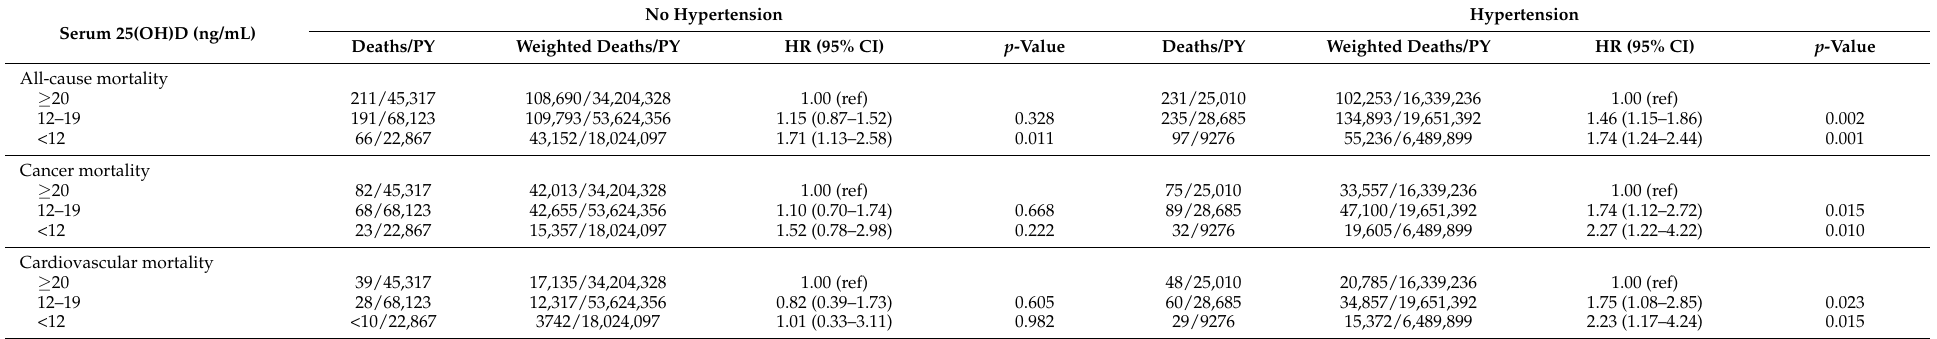
Table 3. Multivariable-adjusted hazard ratios (HRs) and 95% confidence intervals (CIs) for the association of serum 25(OH)D with all-cause, cancer, and cardiovascular mortality stratified by hypertension